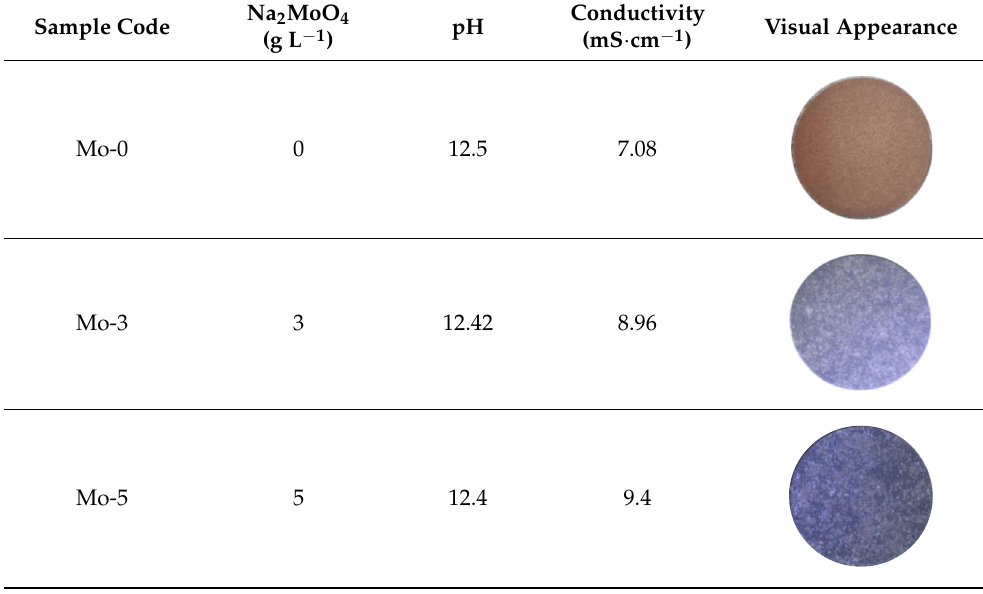
Table 1. Sample codes, pH, conductivity, and coating visual appearance of the coatings produced in various baths with different amounts of Na 2 MoO 4 .